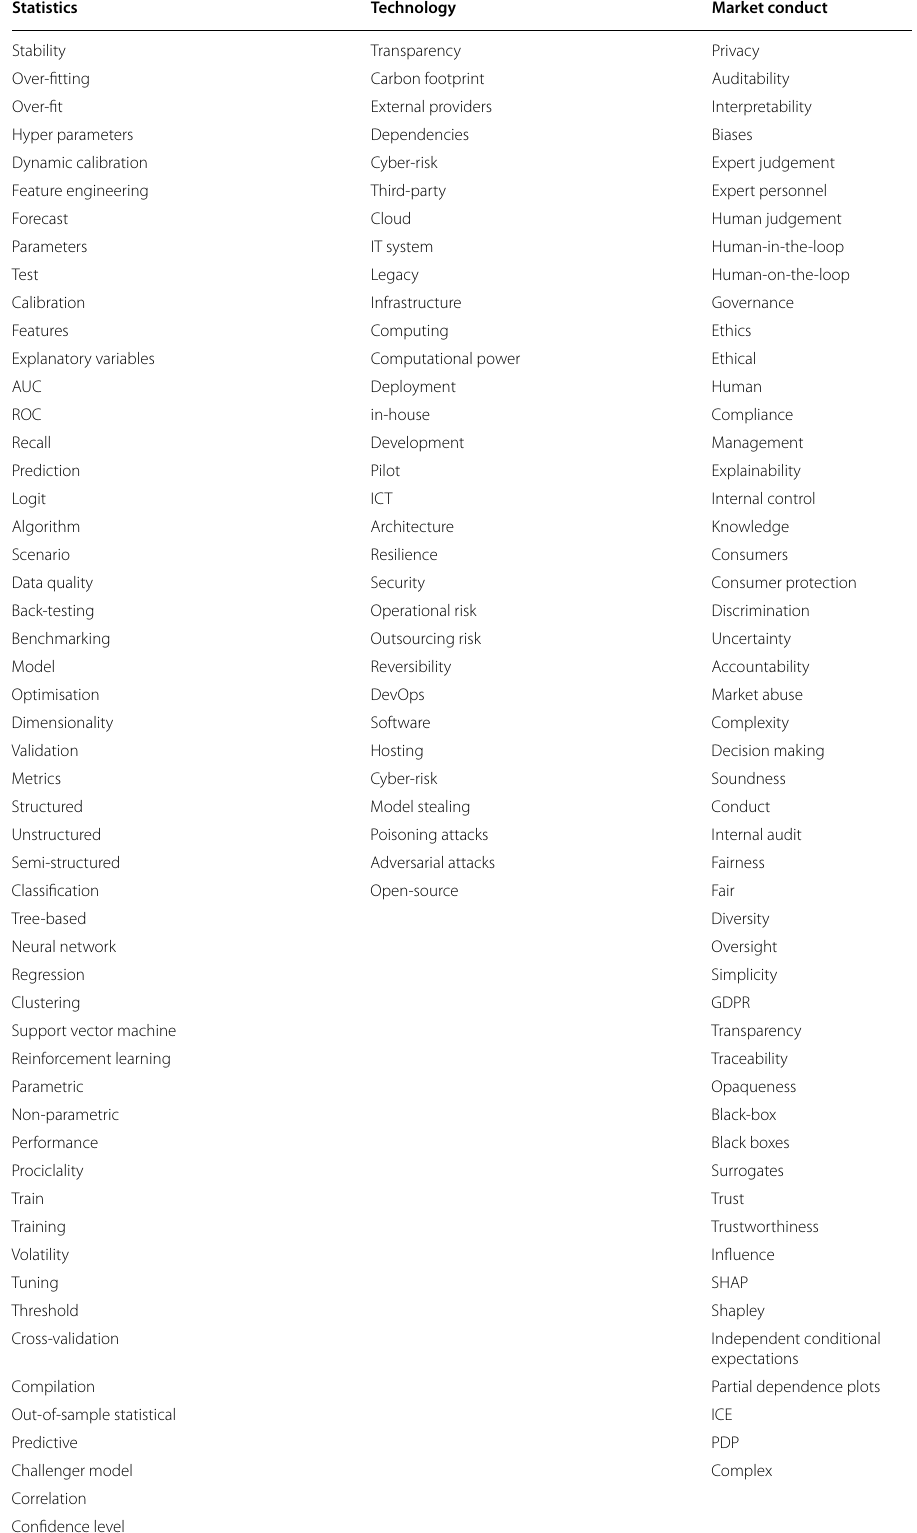
Table 11 Terminology for each model risk